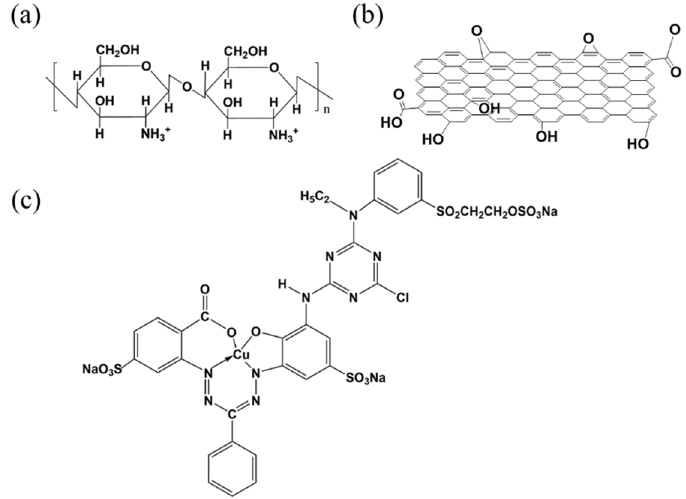
Figure 1. Chemical structures of ( a ) β-chitosan (CS), ( b ) graphene oxide (GO), and ( c ) reactive Blue 221 Dye (RB221).